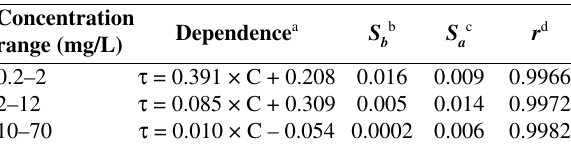
Table 1. Linear ranges for chronopotentiometric determination of riboflavin Concentration